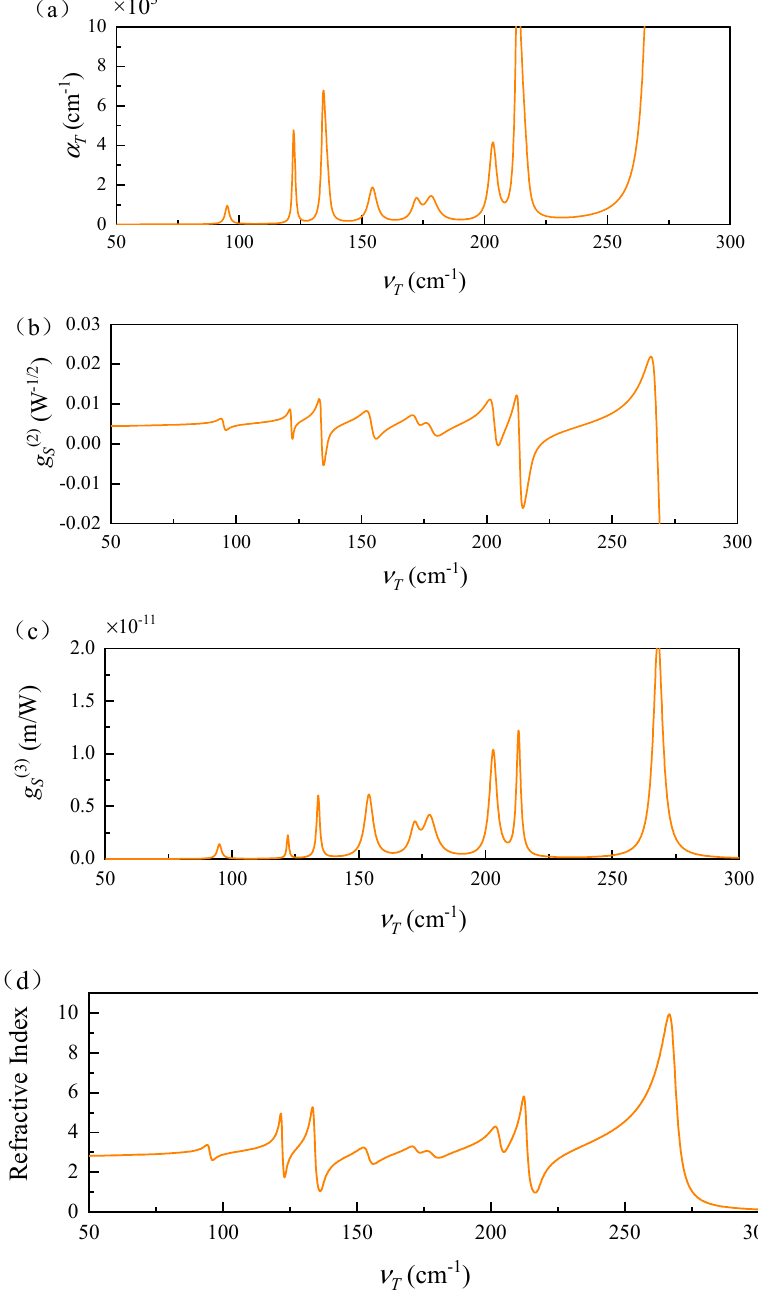
Figure 5. Calculated parameters of KTP crystal. ( a ) The absorption coefficient α T for the terahertz wave. ( b ) Second-order gain coefficient 𝑔 (cid:3020)((cid:2870)) . ( c ) Third-order gain coefficient 𝑔 (cid:3020)((cid:2871)) . ( d ) Refractive index in terahertz region. KTP: KTiOPO 4 ; ν T : wavenumber of the terahertz wave.